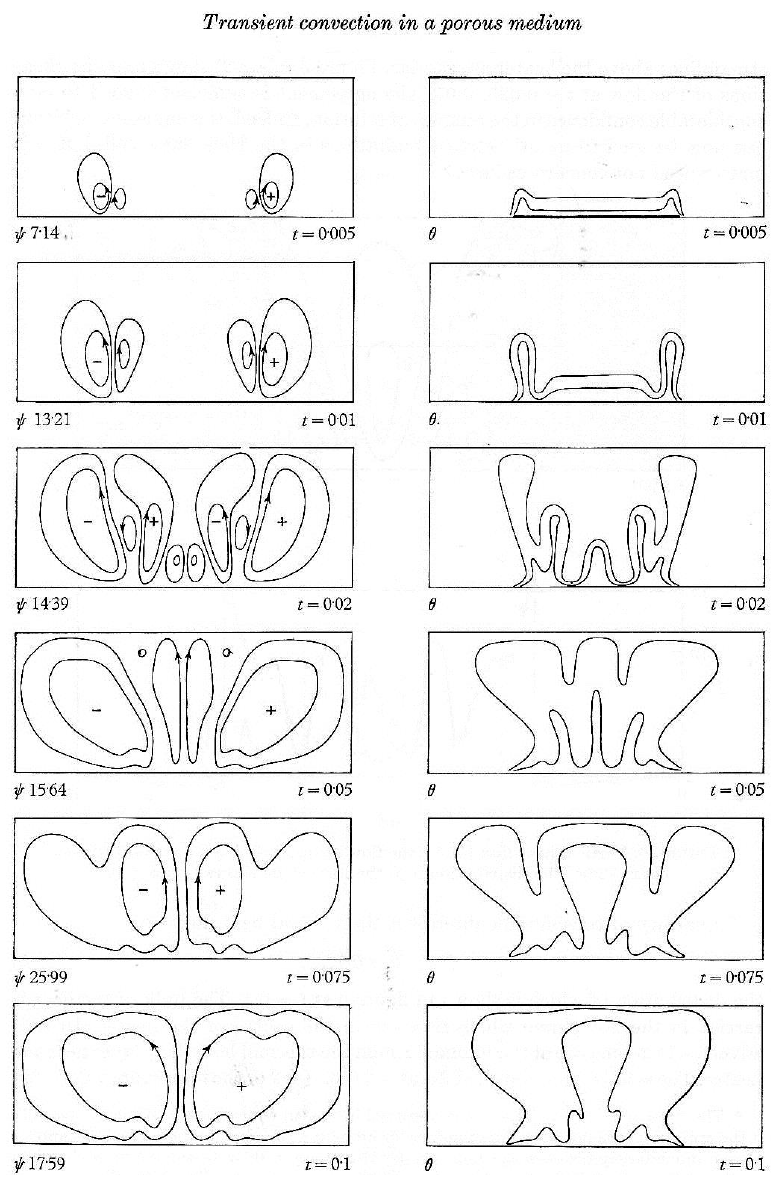
Figure 2. A = 400: stream-function and temperature distribution for the short heater problem at various dimensionless times ( t = 0.005, 0.01, 0.02, 0.05, 0.075, 0.1). Numerical model, Journal of Fluid Mechanics 1967, 27, 609–623 [2]. The curves show 0.2 and 0.6 of the maximum value. [Figure 4, p. 615, Journal of Fluid Mechanics 1967, 27, 609–623 [2]. Reproduced with permission from Elder, J.W., Transient convection in a porous medium; published by Cambridge University Press, 1967.]